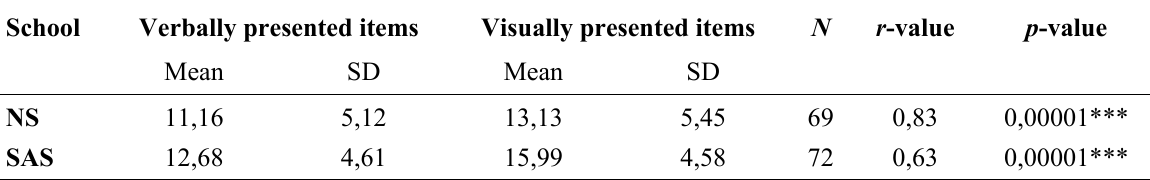
Table 5 : Correlation coefficients for the TPGT by